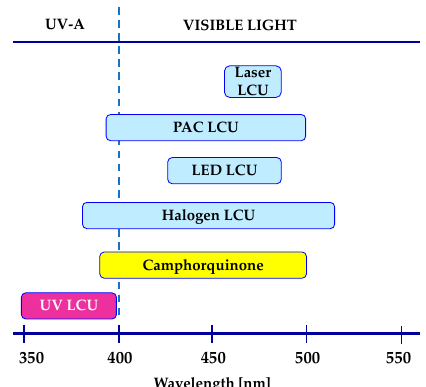
Figure 5. Comparison of the properties of monomers polymerizable via free radical mechanism with monomers polymerizable via cationic mechanism. 3. Commonly Used Photoinitiating Systems for Dental Application Photoinitiating systems for obtaining dental composites are particularly important. They affect such parameters as the efficiency of the photopolymerization process and the choice of a light source (Figure 6).